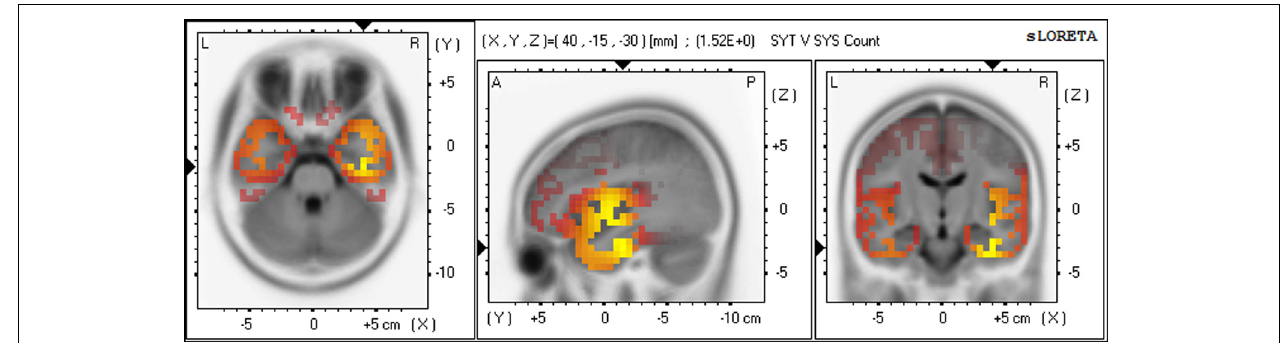
FIGURE 7 | Differences in CSD between groups in gamma band in Non-meditation (Calculation) Increased gamma activity (yellow) in SYT compared to SYS in right BA20 (fusiform gyrus).